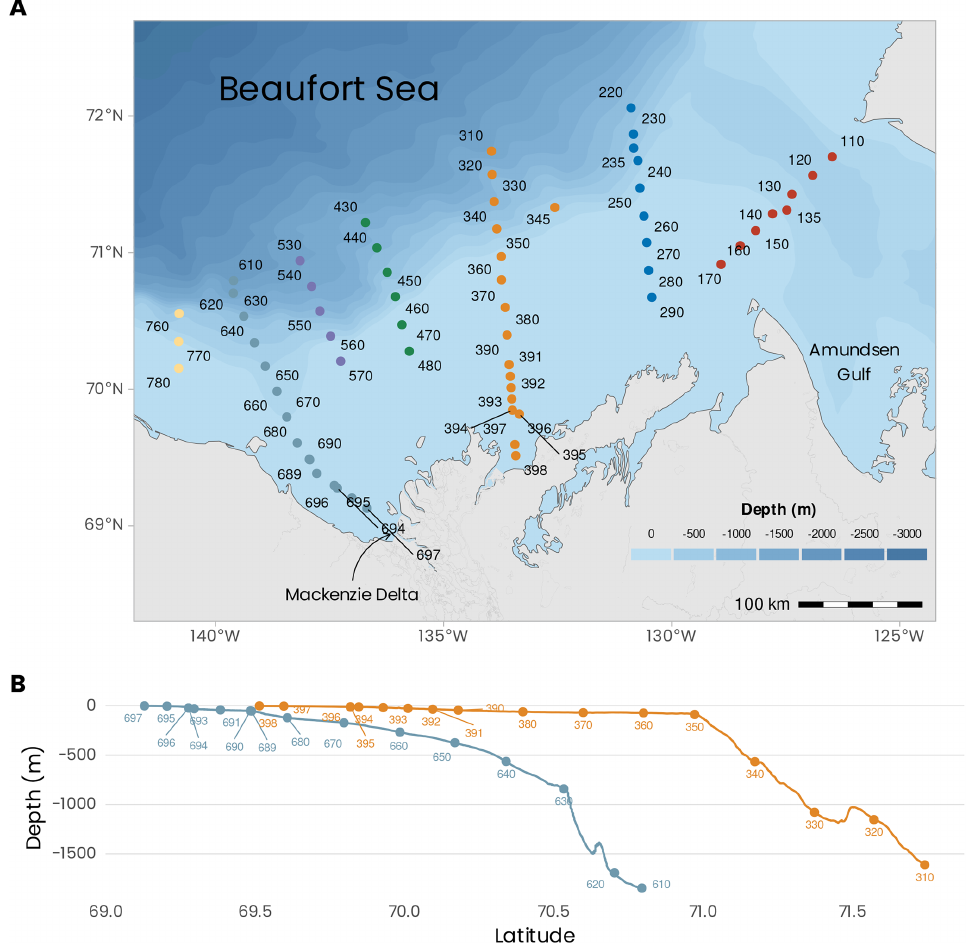
Figure 1. (a) Localizations of the sampling sites visited during the MALINA 2009 campaign. The colors of the dots represent the seven transects visited during the mission. (b) Bathymetric profiles for transects 600 and 300. Bathymetric data from General Bathymetric Chart of the Oceans (GEBCO)